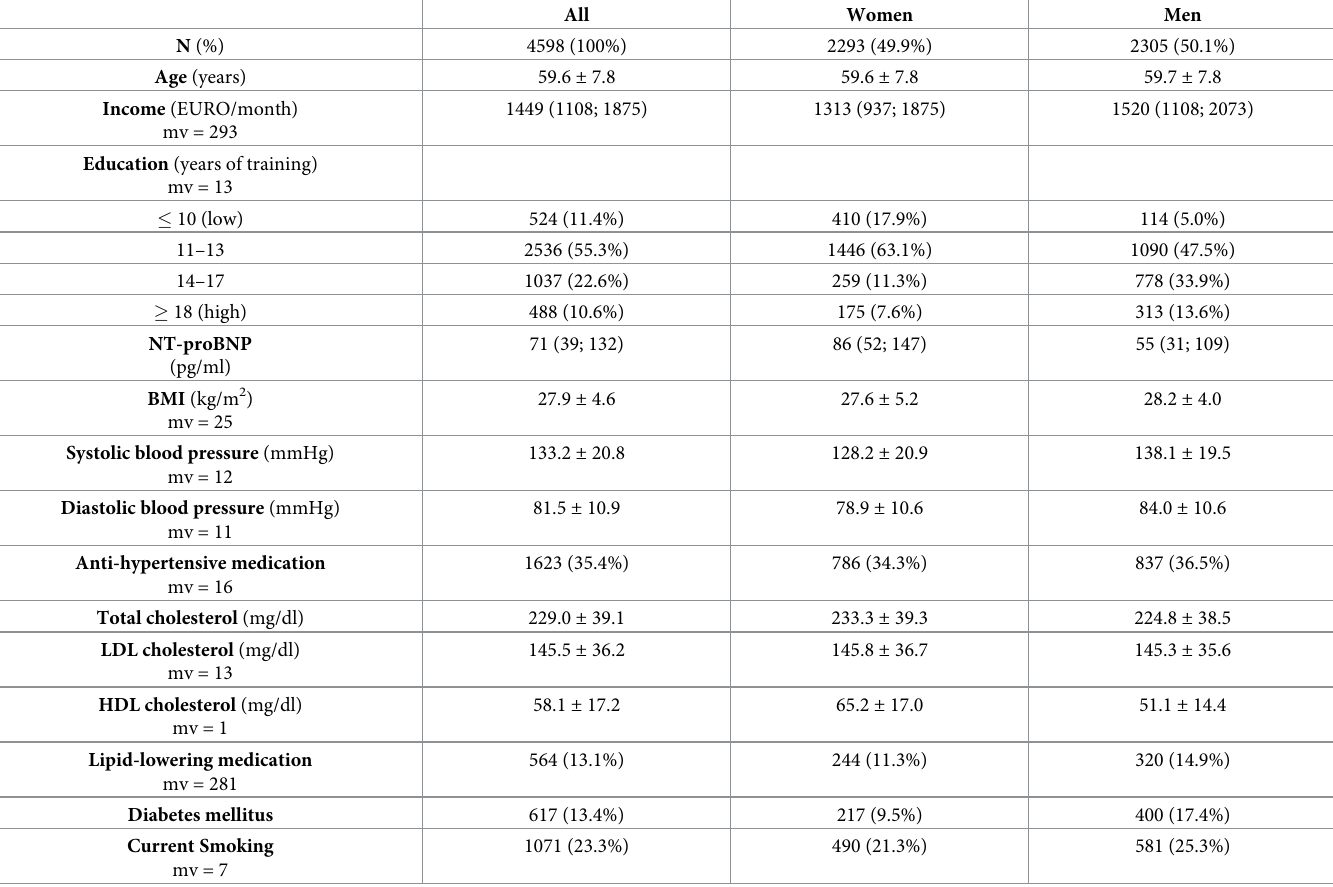
Table 1. Characteristics of the main study population stratified by sex (mv: Number of missing